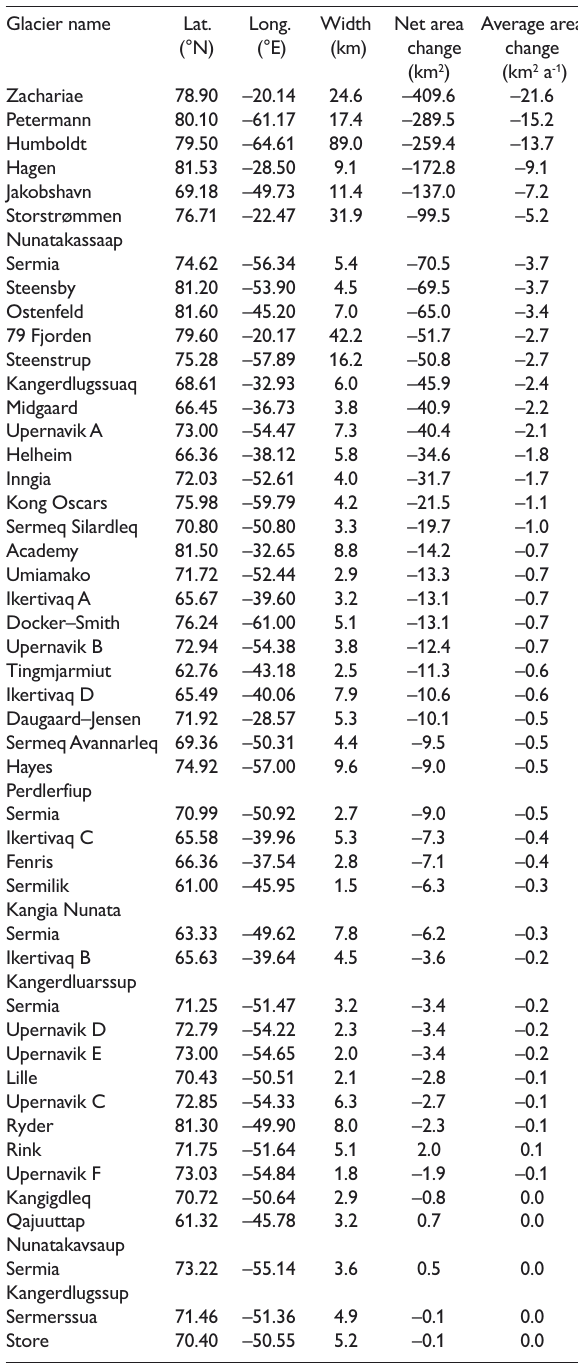
Overview of images used in the mapping of calving front lines